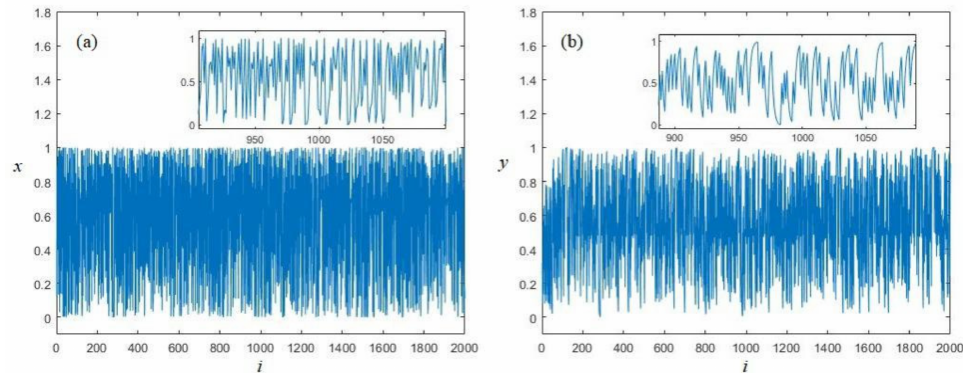
Figure 3. Trajectories of the LB compound chaotic map: ( a ) x-dimensional variable ( b ) y-dimensional variable (sub-figures are the partial